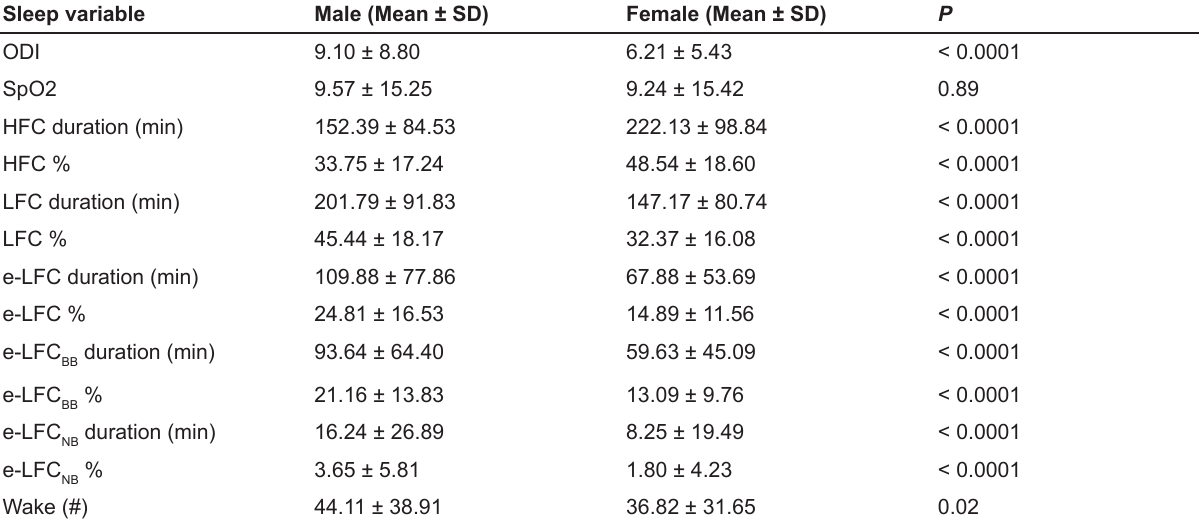
Table 3. Comparison of sleep variables by